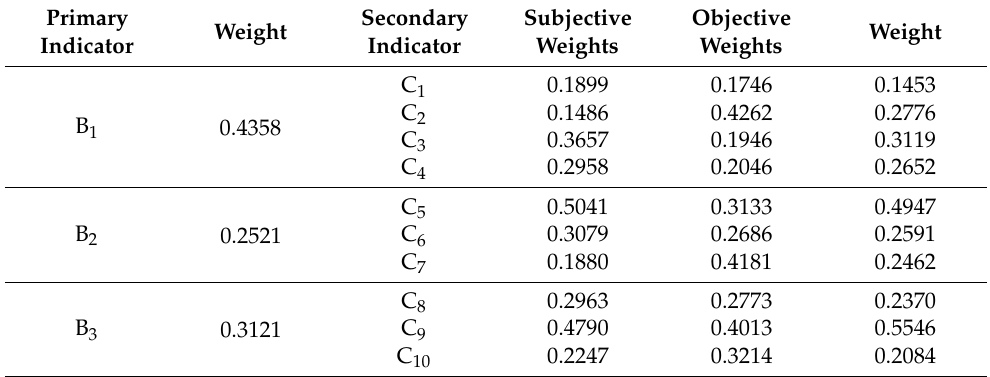
Table 2. Evaluation indicator